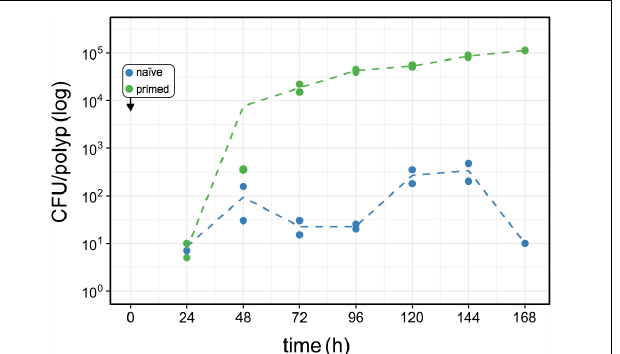
FIGURE 6 | Effects of host-priming on Curvibacter fitness. Population size of primed Curvibacter carrying pRL153-GFP (green) and a naïve Curvibacter wild type (blue) on Hydra over time. Both Curvibacte r strains were added simultaneously to the Hydra pool (box) ( n = 2; dashed line represents the mean population